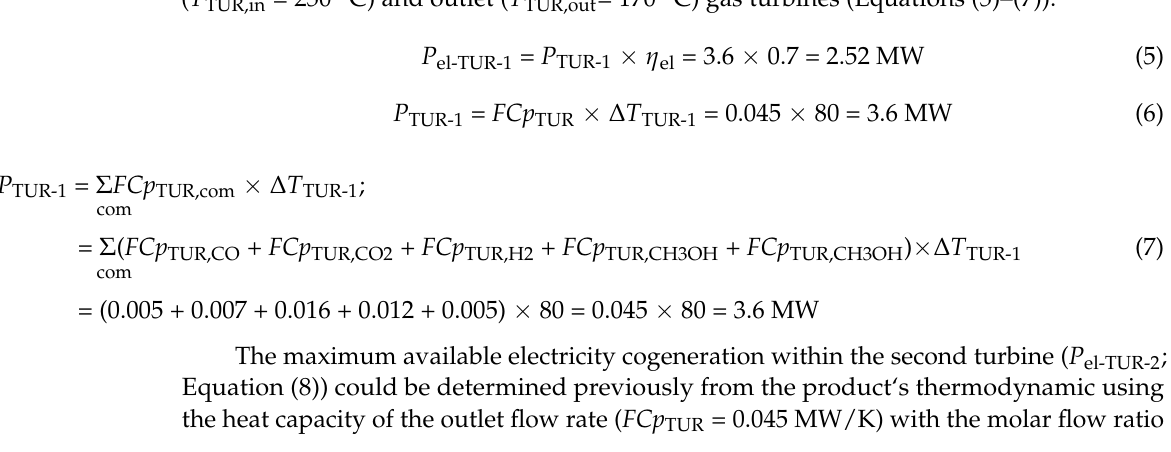
namic using the heat capacity of the outlet flow rate ( FCp TUR = 0.045 MW/K) and the num-